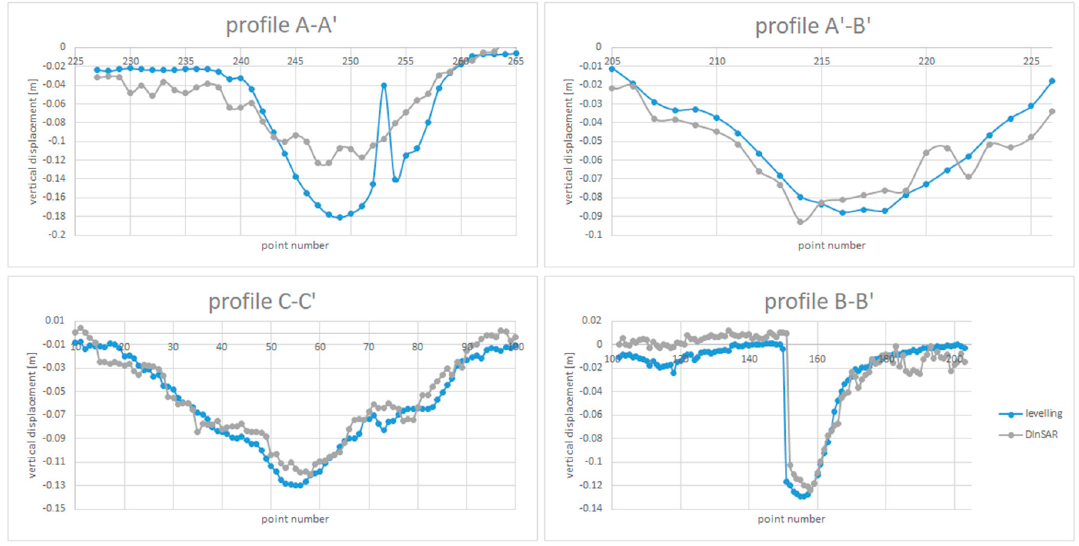
Figure 15. Deformation profiles for vertical component of DInSAR results (gray) and leveling (blue).